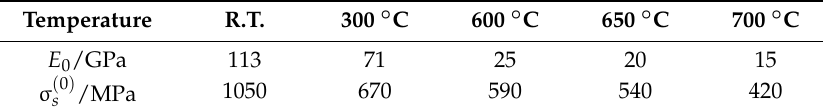
Table 1. The elastic modulus and yield stress of the matrix at different temperatures.